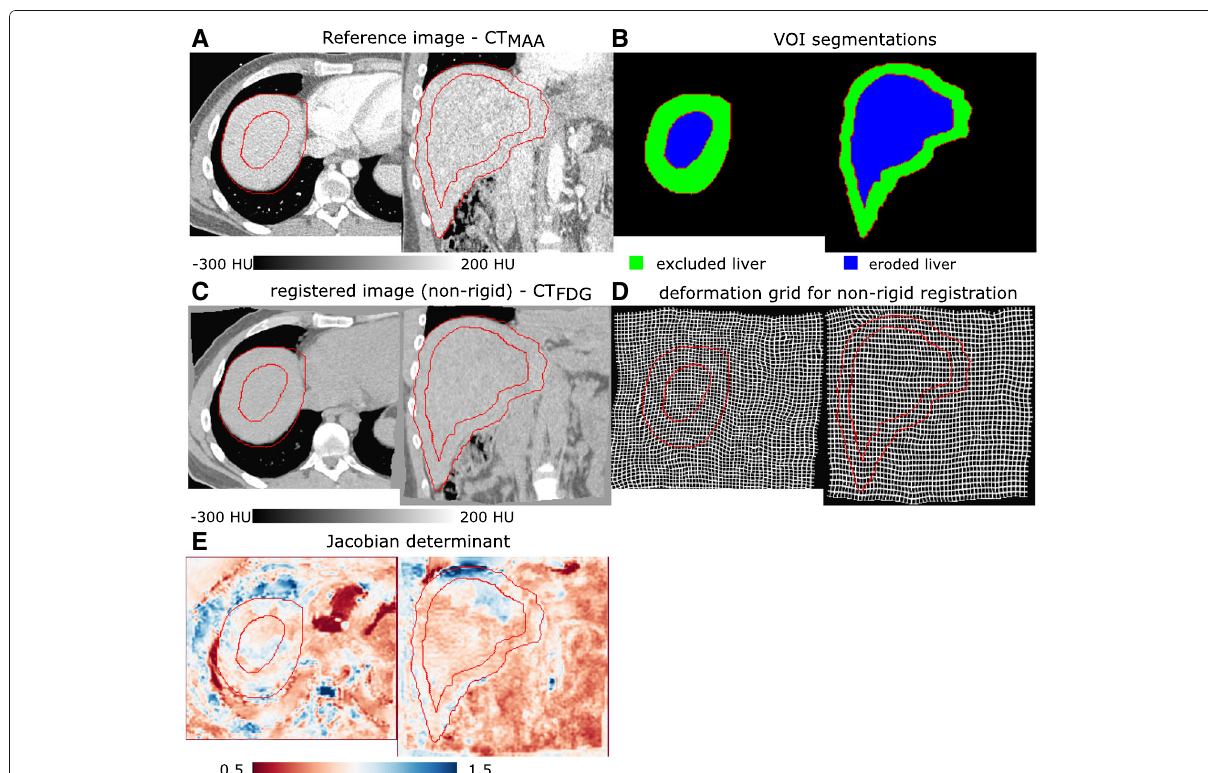
Fig. 8 An example (patient ID BI04 from training set in our database) of transaxial and coronal view of non-rigid registration evaluation for a patient with Likert score of “little misalignment,” the statistics [min, Q1, median, Q3, maximim] of the Jacobian over all liver voxels, eroded liver, and excluded liver for this patient are [0.42, 0.82, 0.89, 0.97, 1.74], [0.58, 0.83, 0.88, 0.96, 1.45], and [0.42, 0.82, 0.90, 0.99, 1.74], respectively, (red contours are from the excluded liver and eroded liver—see b ): a reference image CT MAA , b excluded and eroded liver: eroded liver is manual liver segmentation eroded by 10 mm and excluded liver is the subtraction of excluded liver from liver c and d results of non-rigid registration (CT FDG to CT MAA ) and the deformation grid and e Jacobian determinant of the non-rigid registration: blue, local dilation; red, local contraction; and white, no local volume